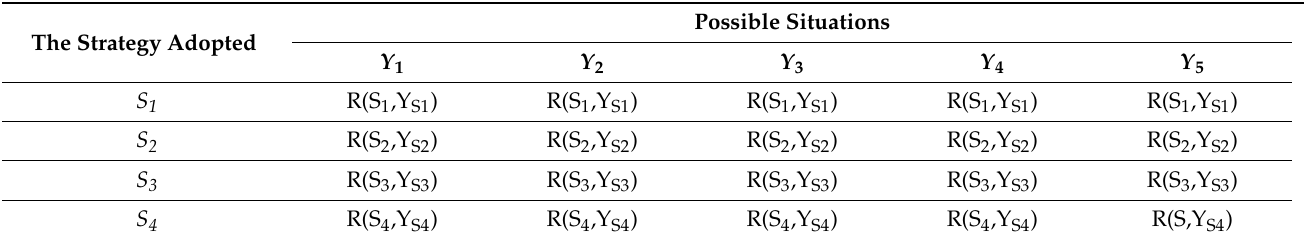
Table 1. The possible cost risk matrix for the production of 2nd generation bioethanol. Y 1 – Y 5 corresponds to strategies from very unfavorable ( Y 1 ) to very favorable ( Y 5 ) production conditions. Possible